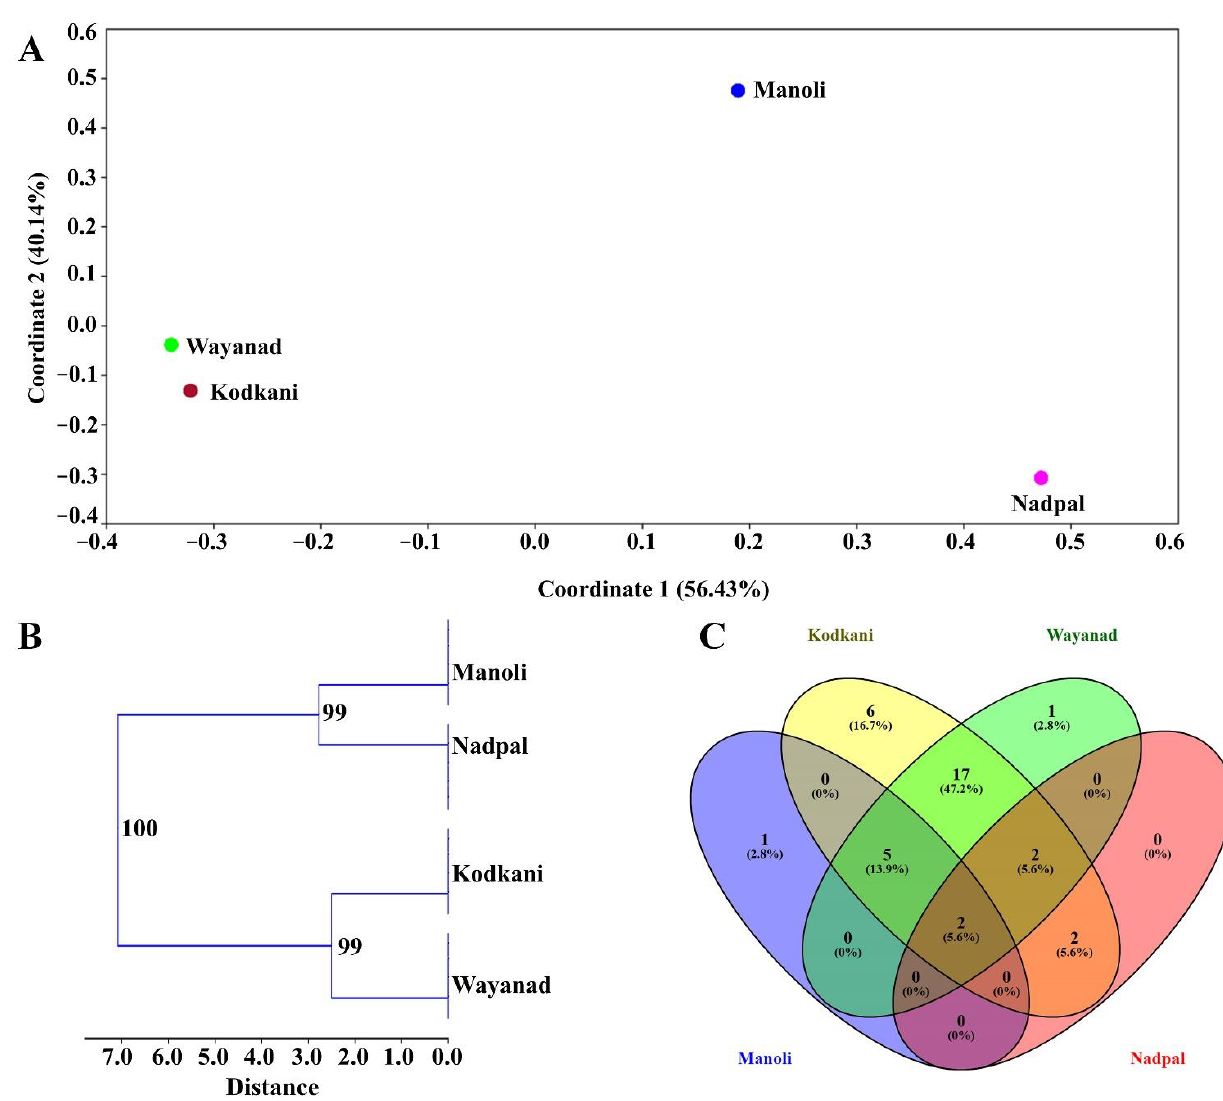
Figure 3. The multivariate analysis of metabolomics data. ( A ) The plot of principle coordinate analysis (PCoA) with identified metabolites across the accessions using the Jaccard coefficient and transformation exponent value 2. The percentage of the variation is captured in Coordinates 1 and 2. The values in parentheses show the percentages of the variation. The x- and y-axes are indicated by the eigenvalue scale. ( B ) A phylogenetic tree with the single linkage algorithm and Jaccard similarity index at the 1000 bootstrapping threshold. The tree shows the clusters among the accessions based on the similarities in the metabolites in each of the five samples of a given accession. Bootstrap values of the respective clusters are depicted at each tree node. ( C ) The Venn diagram depicted the number of compounds shared and uniquely present along with all the combinations. Kodkani and Wayanad accessions show the maximum number of shared compounds, whereas Manoli and Nadpal accessions show the least number of shared compounds. Similarly, Kodkani accession showed a maximum (six) number of uniquely present compounds. However, Nadpal accession does not have any unique one.